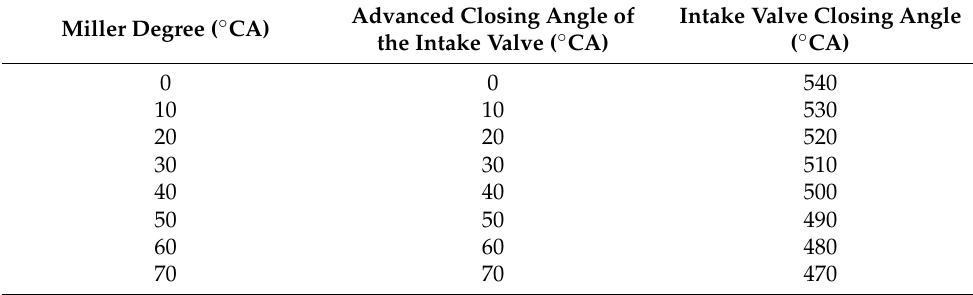
Table 7. Miller cycle scheme of the variable cam line.